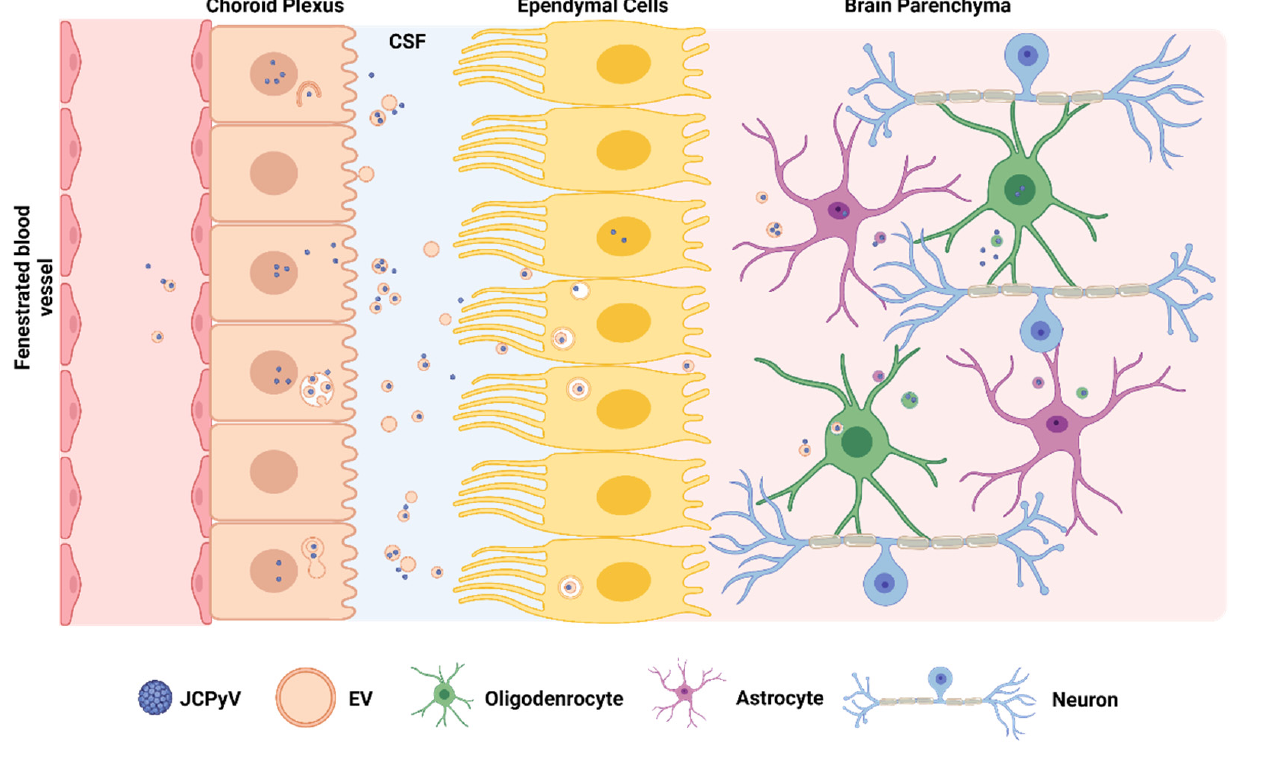
Figure 3. Hypothetical neuroinvasion of JCPyV via the blood-cerebrospinal fluid barrier. JCPyV and/or JCPyV(+) EVs can travel from a blood vessel to choroid plexus epithelial cells (CPE). CPEs are productively infected by JCPyV and package virus into EVs for dissemination to the CSF. JCPYV(+) EVs can travel to/through the ependymal layer (undefined) and invade the brain parenchyma to infect astrocytes and oligodendrocytes. Schematic created with BioRender.com (accessed on 18 April 2022).